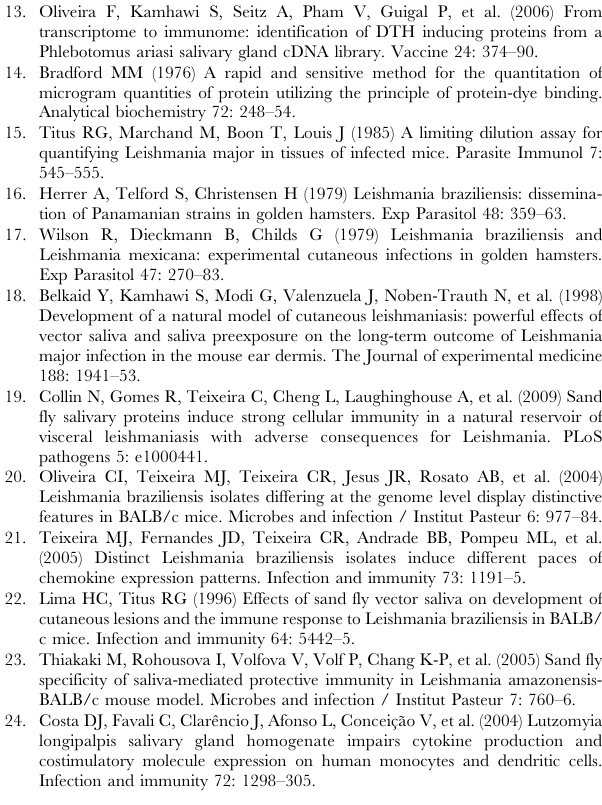
group total) were inoculated three times in the right ear with DNA plasmid coding LJM19 salivary protein or empty DNA plasmid (CTR) and were challenged intradermally in the left ear with 10 5 L. braziliensis stationary promastigotes in the presence of Lu. intermedia SGS. Five weeks after the infection, the parasite load was evaluated in the draining lymph node by LDA and estimated by ELIDA. Experiments were repeated three times and were evaluated by Mann-Whitney non-parametric t test. *p , 0.05. Figure S4 Parasite load in LJM19 DNA plasmid or Lu. longipalpis SGS immunized hamsters following infec- tion with L. braziliensis . Hamsters (9 per group total) were inoculated three times in the right ear with DNA plasmid coding LJM19 salivary protein or Lu. longipalpis SGS (closed bars) or empty DNA plasmid (CTR) or Saline (open bars) and were challenged intradermally in the left ear with 10 5 L. braziliensis stationary promastigotes in the presence of L. intermedia SGS. The parasite load was evaluated 5 weeks after infection in the ear (A) and draining lymph node (B) by LDA, estimated by ELIDA. Bars represent the median and standard errors of the means. Experiments were repeated three times and were evaluated by ANOVA (Kruskal-Wallis) analysis with Dunn’s post-test. *p , 0.05; **p ,